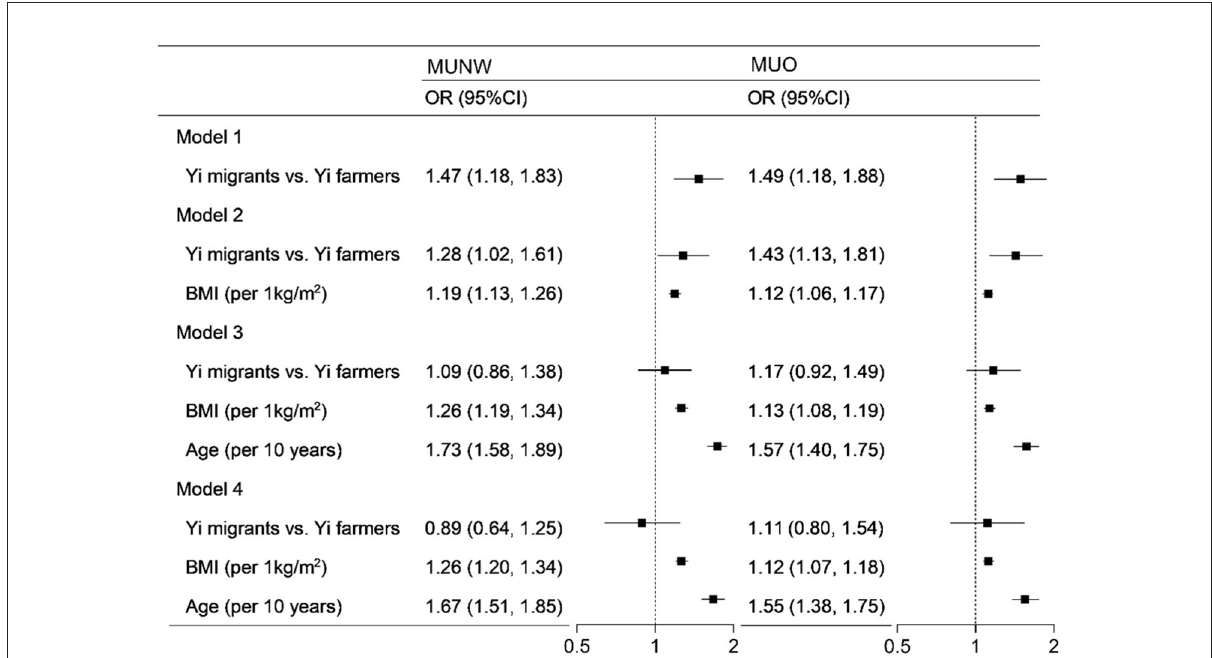
FIGURE1 Logistics regression analysis of the association between rural-to-urban migration, age, and BMI with metabolically unhealthy phenotype. MUNW, metabolically unhealthy and normal-weight; MUO, metabolically unhealthy overweight/obesity; OR, odds ratio; BMI, body mass index. In the MUNW models, the MHNW was the control, and in the MUO models, the MHO was the control. Model 1 included rural-to-urban migration. Model 2 included model 1 plus BMI. Model 3 included model 2 plus BMI and age. Model 4 included model 3 plus sex, education, income, smoking status, drinking status, occupational physical activity, and leisure-time